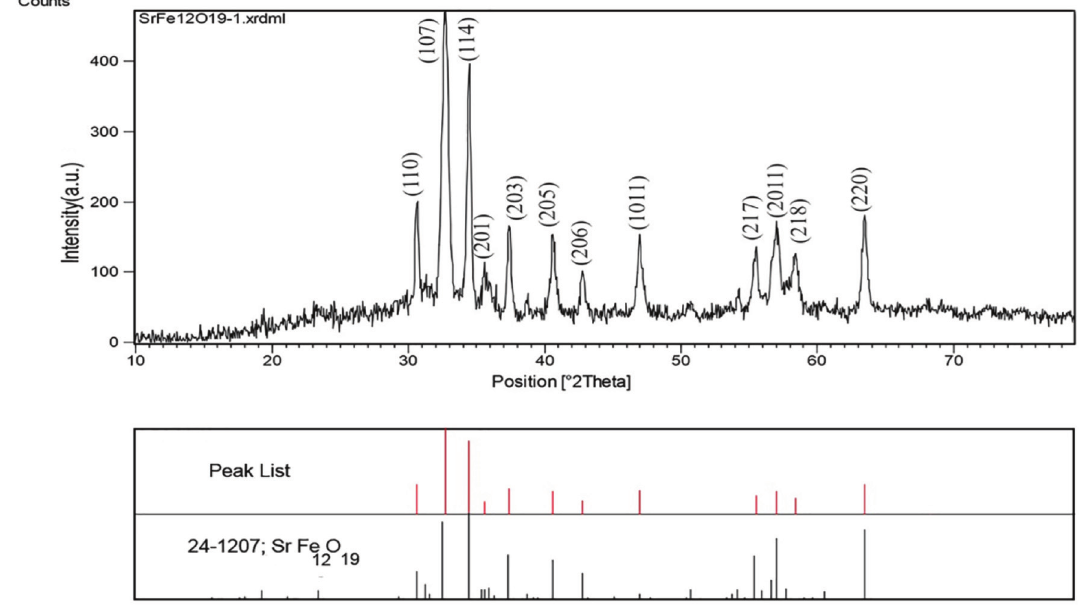
Figure 2: XRD pattern of the SrFe